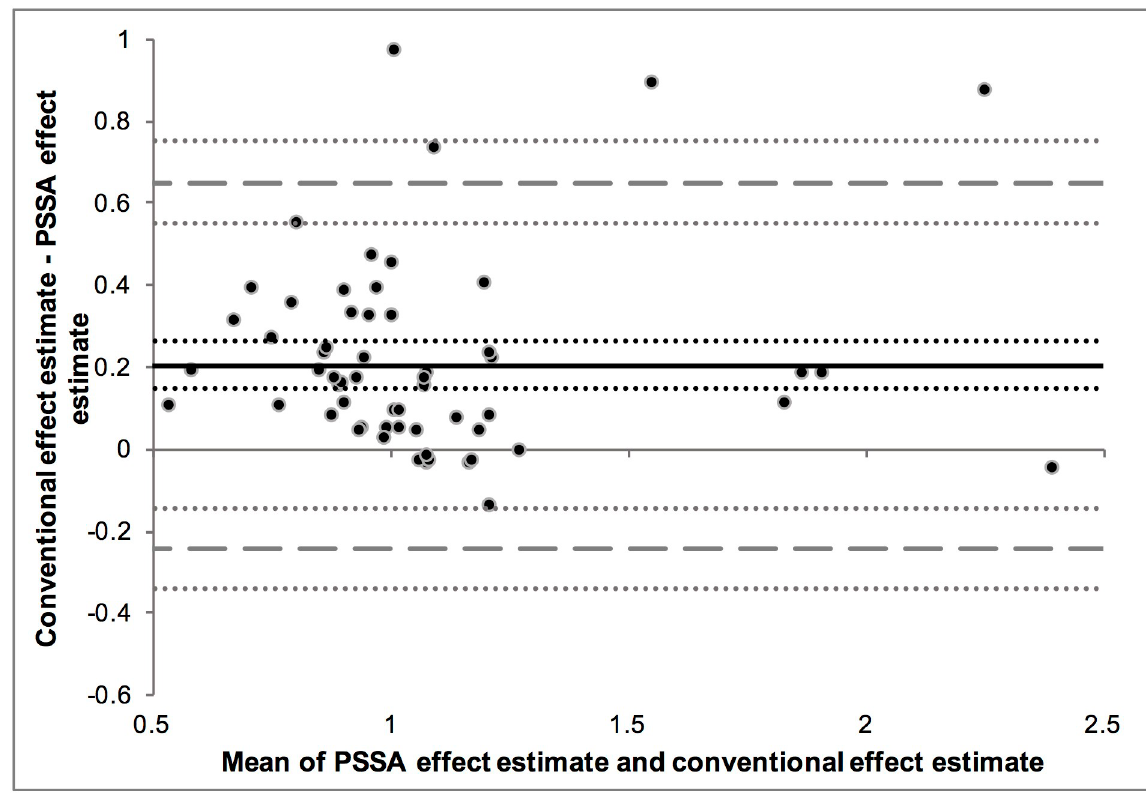
Fig 4. Bland-Altman plot of the difference between the effect estimates plotted against their mean. The black dots represent the difference against the mean of the effect estimate pairs; the black continuous line is the mean difference between the effect estimates (with 95% CI represented by the black dotted lines); the grey dashed lines represent the upper- and lower limit of agreement (with 95% CI’s represented by the grey dotted lines).